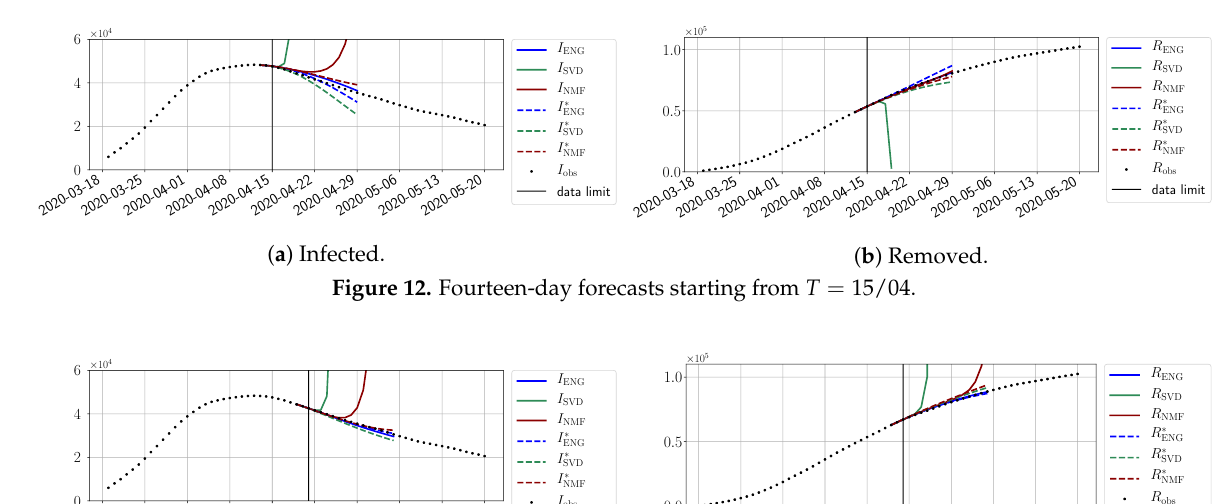
Figure 11. Fourteen-day forecasts starting from T = 11/04.